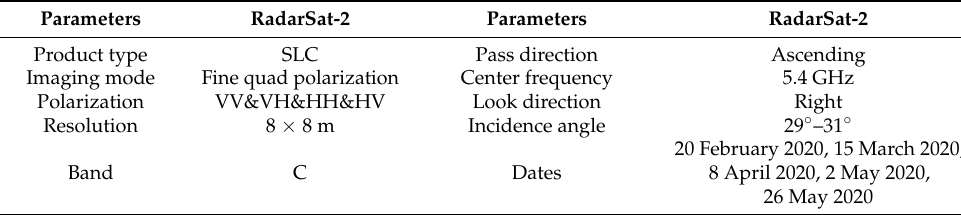
Table 1. Parameters for